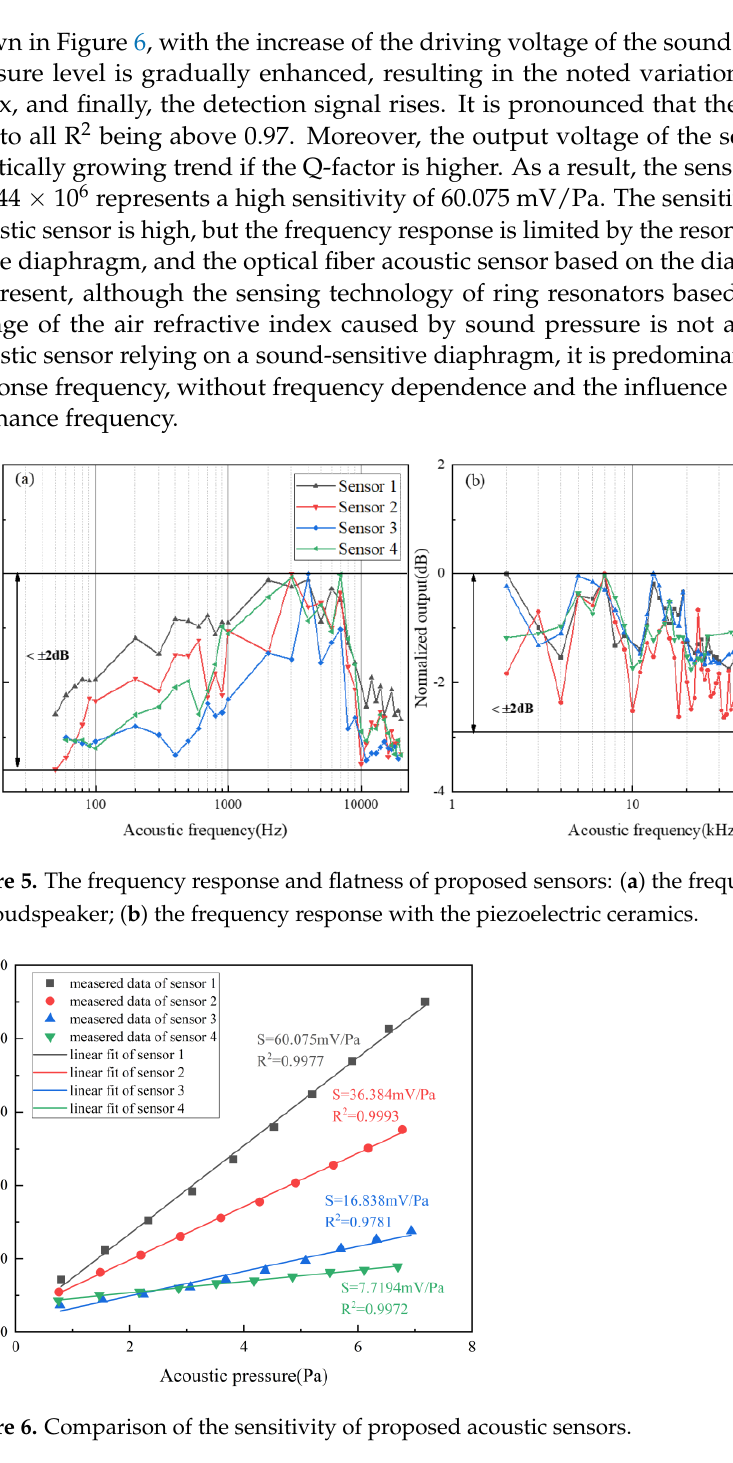
Figure 5. The frequency response and flatness of proposed sensors: ( a ) the frequency response with the loudspeaker; ( b ) the frequency response with the piezoelectric ceramics.